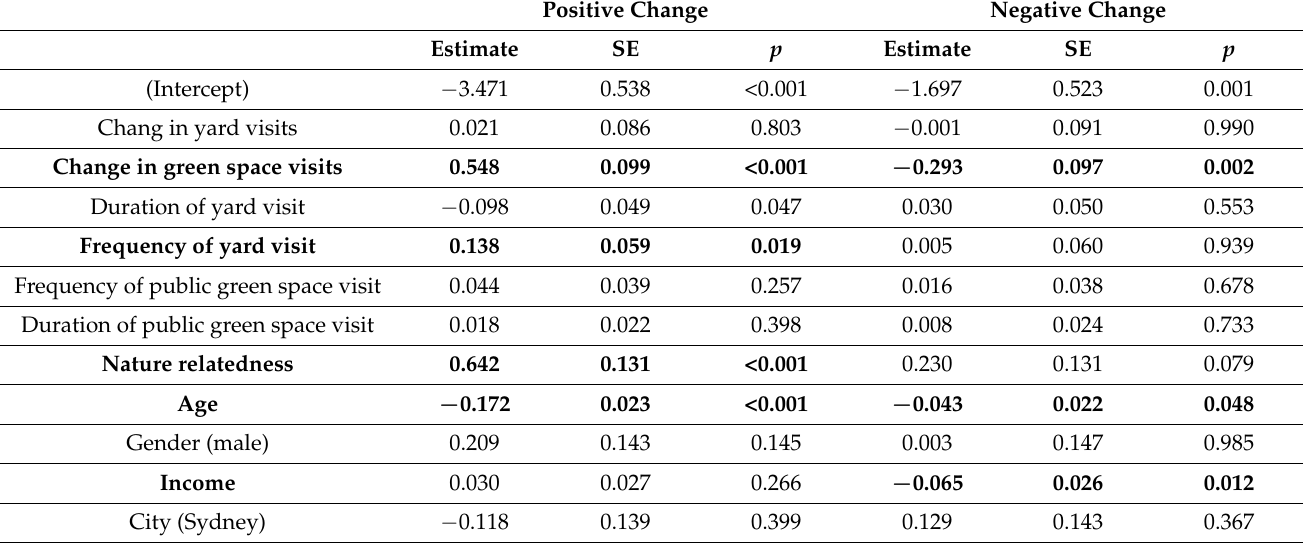
Table 2. Change in nature experience and change in health and wellbeing (positive and negative) over the first year of the COVID-19 pandemic, after controlling for demographic factors. Positive